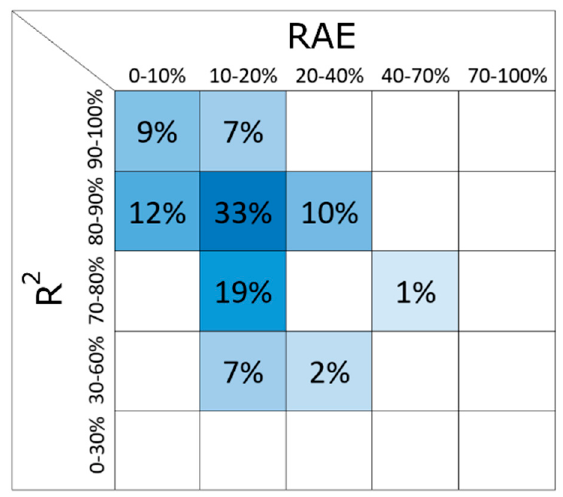
Figure 10. Q-learning classification error matrix.